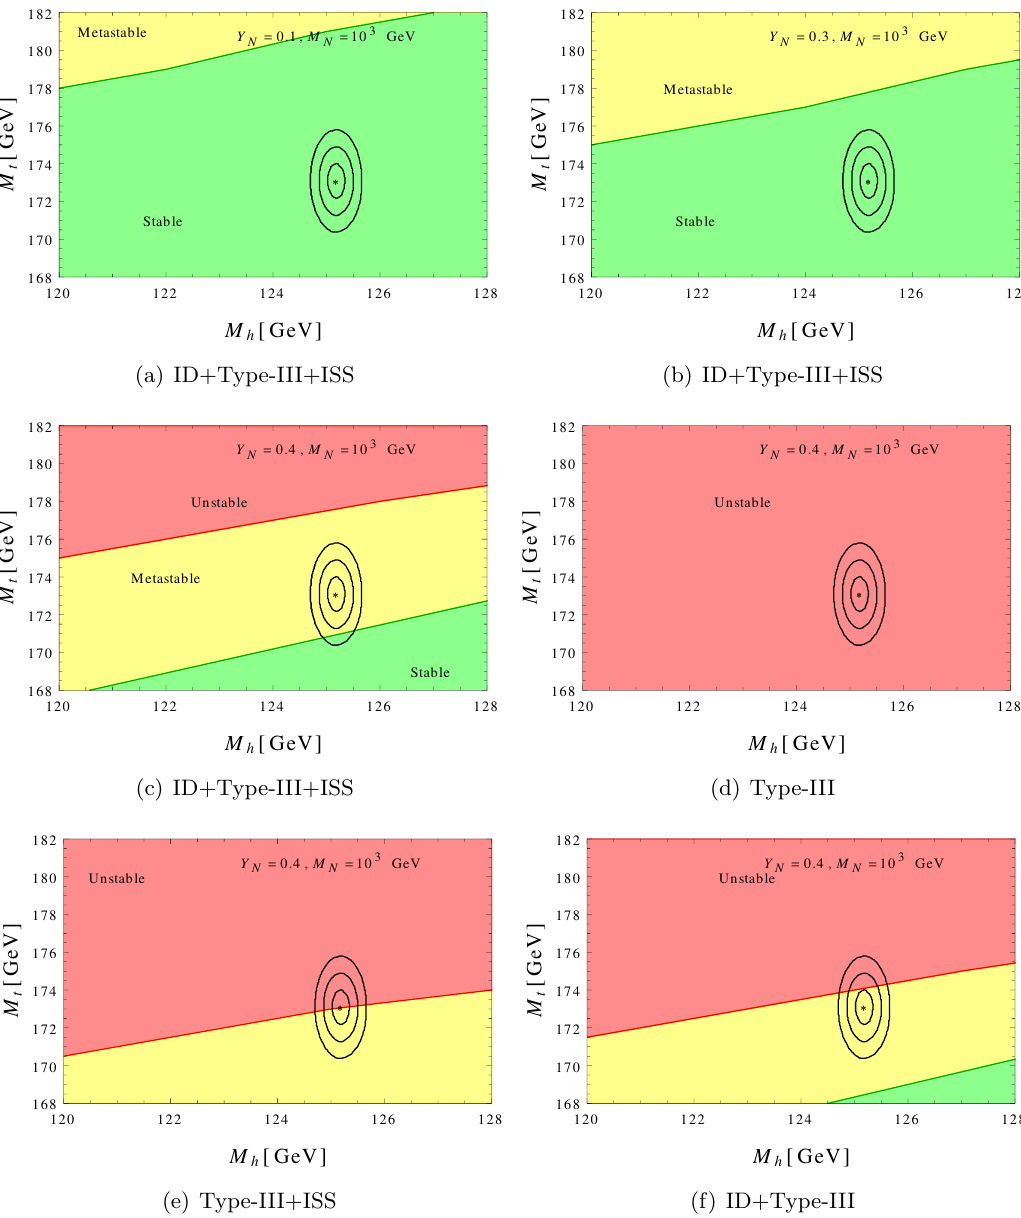
Figure 9 . Phase diagram in terms of Higgs and top pole masses in GeV with M N = 10 3 GeV in (cid:12)gures 9(a), 9(b), 9(c) for ID+Type-III+ISS scenarios with Y N = 0 : 1 ; 0 : 3 ; 0 : 4 respectively. Fig- ure 9(d) is for Type-III only and (cid:12)gures 9(e), 9(f) are for Type-III+ISS with Y N = 0 : 4. The unstable, metastable and stable regions are depicted by the colours red, yellow and green respec- tively. The contours describe the current experimental 1 (cid:27); 2 (cid:27); 3 (cid:27) values with the dot specifying the central value in the ( M h ; M t )